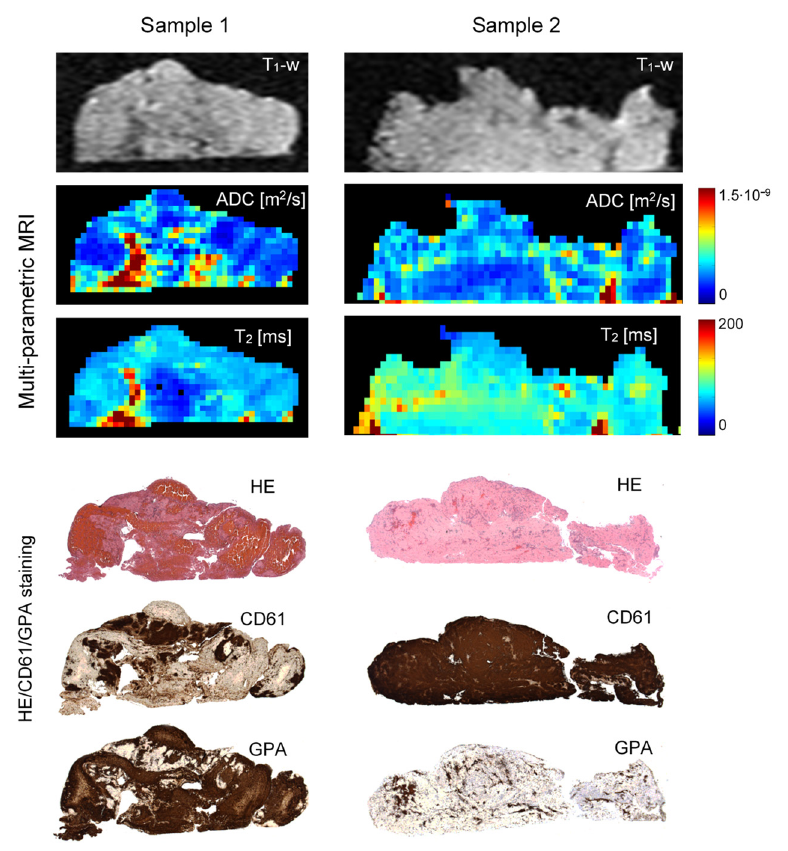
Figure 3. Two representative cerebral thrombi of a different structure are presented by central-slice T 1 -weighetd images, ADC and T 2 maps along with the corresponding histological (HE/CD61/GPA) images. Lower ADC and T 2 values, shown in dark blue, in maps of Sample 1 correspond to compact RBC-rich regions, while lower ADC and T 2 values in Sample 2 correspond to compact platelet-fibrin- rich regions. CD61 staining is specific to platelets (dark brown), while GPA staining is specific to RBC components (dark brown).